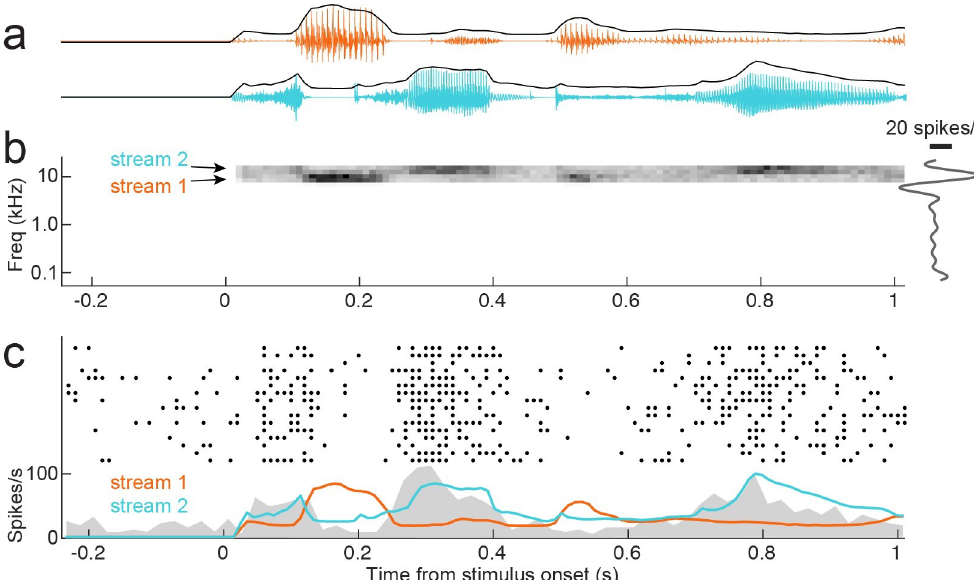
Fig 1. A. Two example natural vocalization waveforms show characteristic interspersed epochs of high sound energy and silence. Each sound has a distinct envelope tracing amplitude over time, which captures these complex temporal dynamics. B. Spectrogram of vocalization-modulated noise presented to one A1 neuron. Stimuli were generated by applying vocalization envelopes to narrowband noise, capturing the complex temporal dynamics of natural sounds. For the two-band stimulus, a different envelope was applied to adjacent, non-overlapping spectral bands. Both noise streams were positioned in the responsive area of a frequency tuning curve (right). Thus vocalization-modulated noise enabled probing natural, nonlinear temporal processing while minimizing complexity of spectral features. C. Raster response the same neuron to repeated presentations of the vocalization-modulated noise stimulus (top), and peri-stimulus time histogram (PSTH) response averaged across repetitions (gray shading, bottom). The envelope of each noise stream is overlaid. Increased amplitude in stream 2 (blue) leads to a strong onset response that weakens after about 50 ms (transients in the PSTH at 0.25 s and 0.8 s). Stream 1 (orange) suppresses the PSTH, with no evidence for